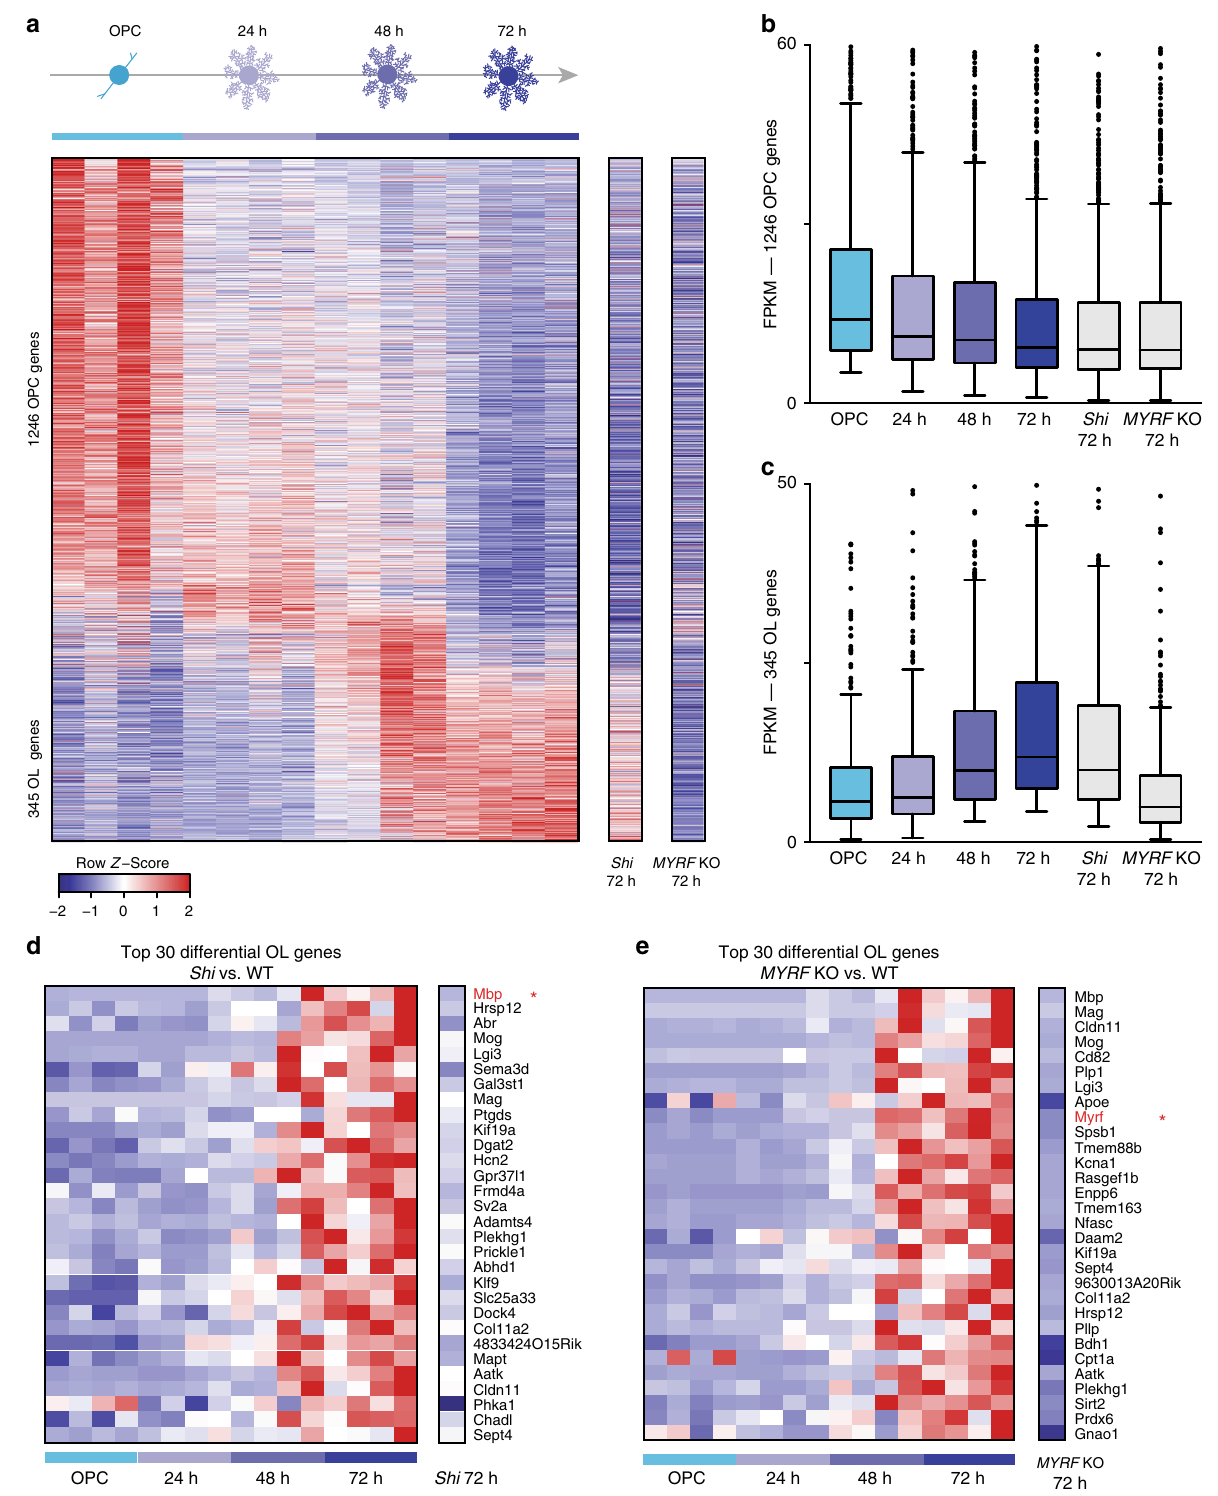
Fig. 3 Molecular pro fi ling of spontaneous and purposely generated mutant oligodendrocyte alleles. a Row normalized heatmap with genes (rows) sorted by time of maximum (TOM). The four independent WT mESC lines for each time point are shown compared to gene expression of shiverer and MYRF KO OPCs 72 h post T3 induction. b Boxplot of OPC-signature genes prior to T3 induction and after differentiation with T3 for 24, 48, and 72 h. c Boxplot of oligodendrocyte-signature genes prior to T3 induction and after differentiation with T3 for 24, 48, and 72 h. d Row normalized heatmap of the top 30 dysregulated oligodendrocyte-signature genes for shiverer 72 h post T3 induction. Gene expression for the four WT mESC strains for each time point are shown compared to gene expression of shiverer OPCs 72 h post T3 induction. Note the lack of MBP expression (red star). e Row normalized heatmap of the top 30 dysregulated oligodendrocyte-signature genes for MYRF KO OPCS at 72 h post T3 induction. Gene expression for the four WT mESC strains for each time point are shown compared to gene expression of MYRF KO OPCs 72 h post T3 induction. Note the lack of MYRF expression (red